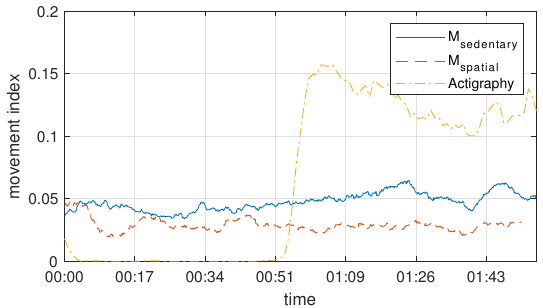
Figure 6. An extreme example of the proposed method and the use of actigraphy sensor. The actigraphy sensor is worn on a specific part of the body, so it may not reflect the whole movement (the first 50 s) or over-reflected (the last 50